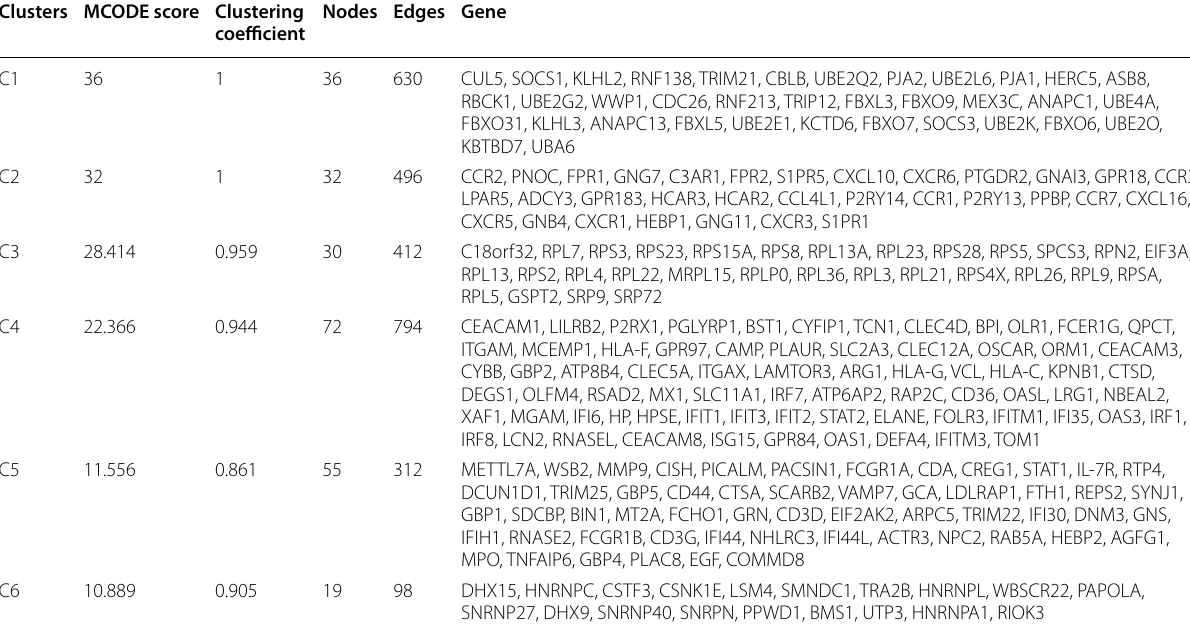
C1–C6 are that ensure the effectiveness of functional partners towards the core network of T2DM-TB DEGs